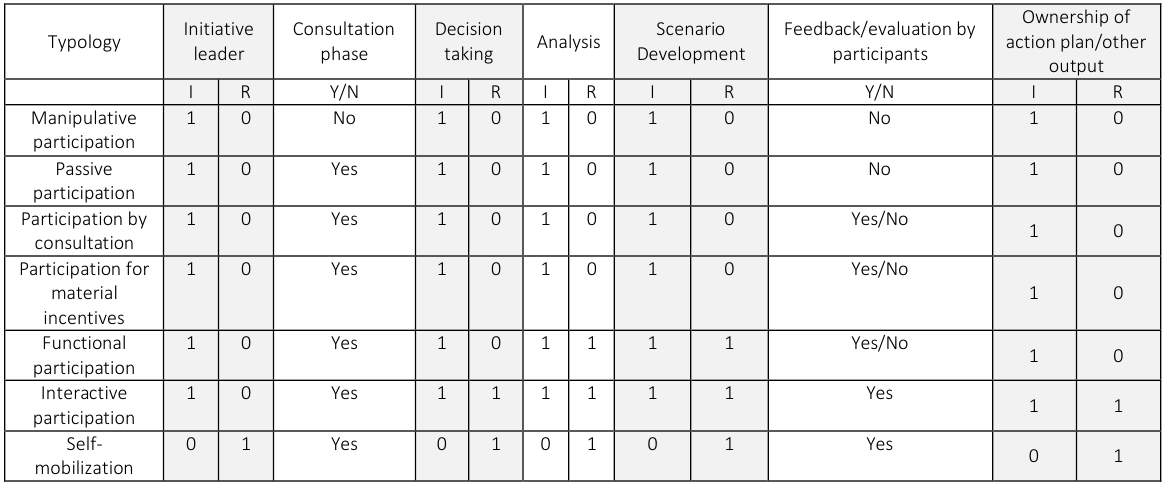
Table A1.2. Pretty’s typology in the context of participatory future scenario development. The columns account for different steps of the research process, and distinguish stakeholders as implementors (I) and receivers (R) according to White’s